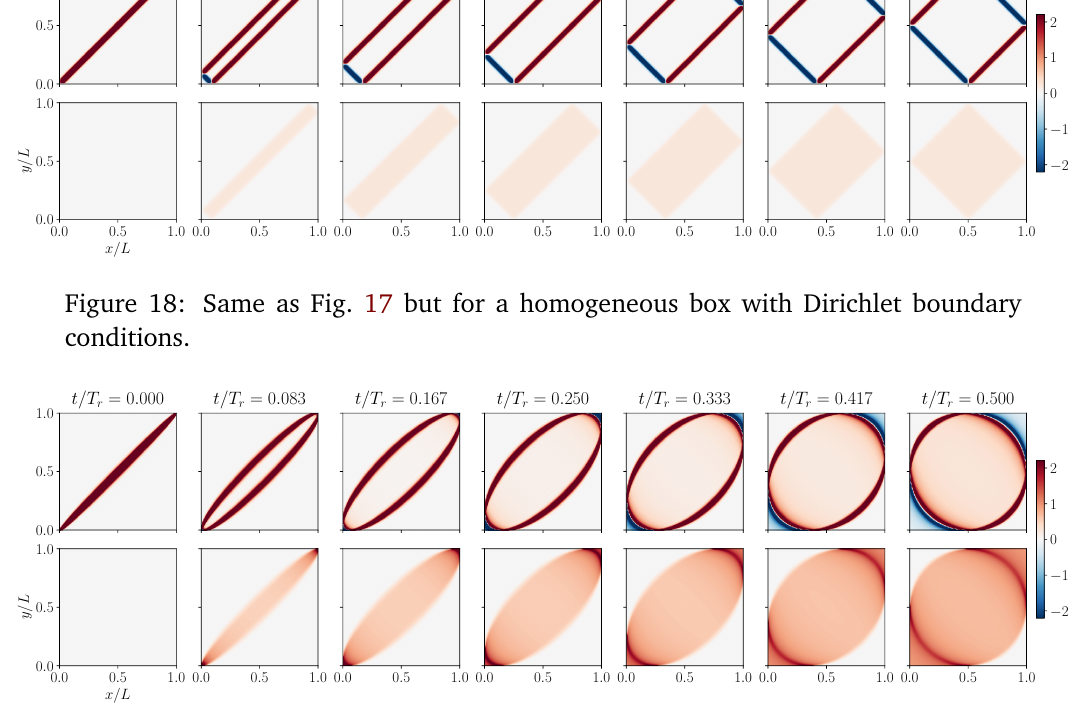
Figure 19: Same as Fig. 17 but for a parabolic trap as described by the Thomas-Fermi